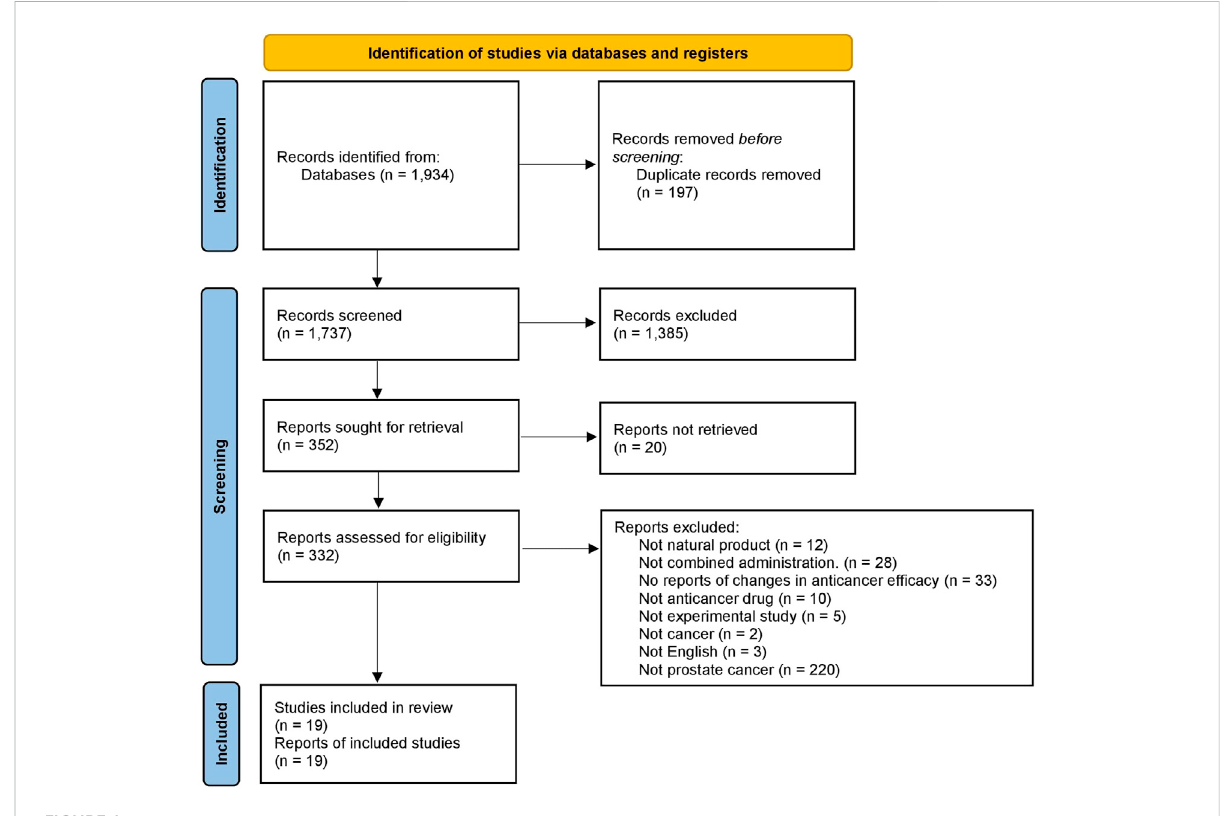
FIGURE 1 PRISMA fl ow diagram of study selection